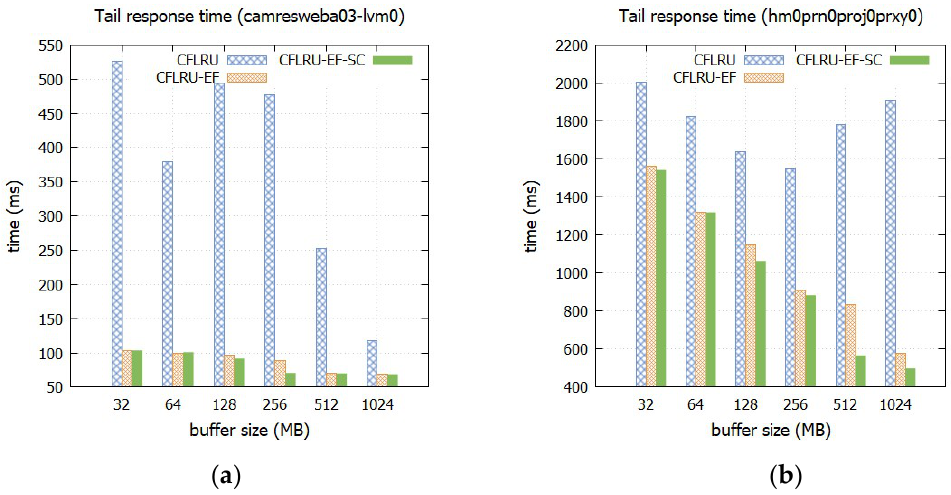
Figure 5. Tail response time. ( a ) camresweba03-lvm0; ( b )